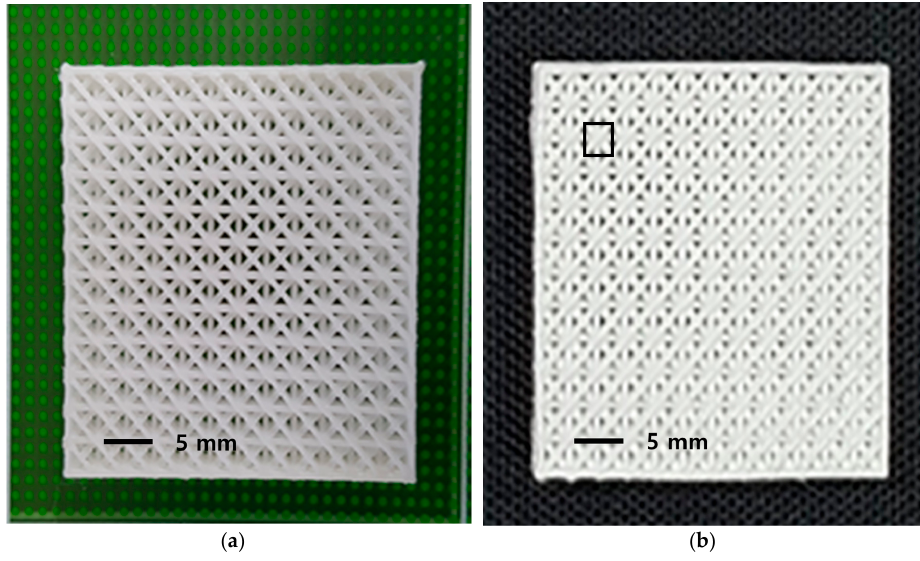
Figure 1. The solid freeform fabricated by 3D printing technology ( a ); and foamed structure after 3D printing via gas foaming process ( b ). printing via gas foaming process ( b